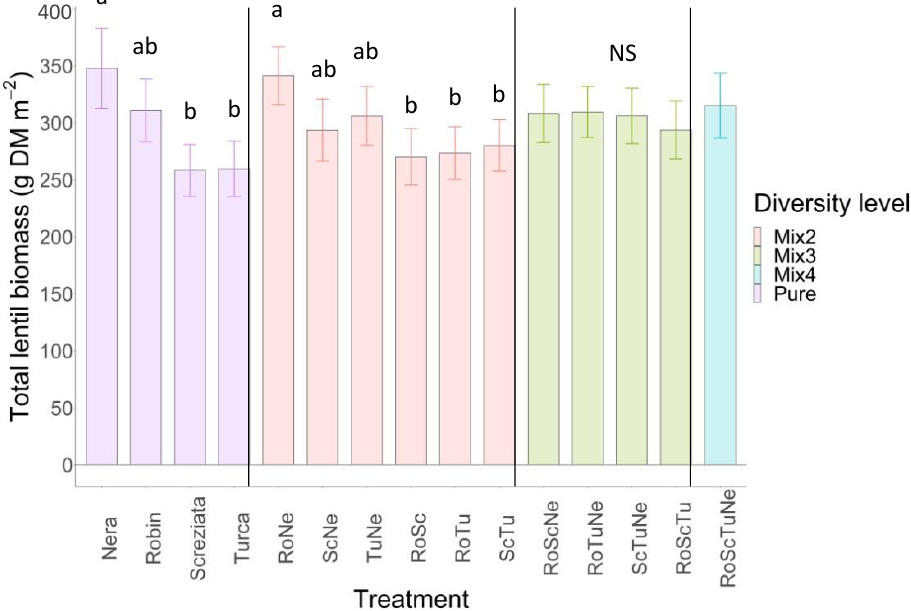
Figure 3. Lentil biomass differences among pure stands, mixtures of two cultivars, mixtures of three cultivars and mixtures of four cultivars: average of the three years of experiment. Values are the above-ground biomass dry weight, expressed as g/m2. Different letters indicate statistical significance at the p ≤ 0.05 level (Bonferroni-based method) among treatments. NS means no statistical significance with p ≤ 0.05. Ne = Nera, Ro = Robin, Sc = Screziata, Tu = Turca.